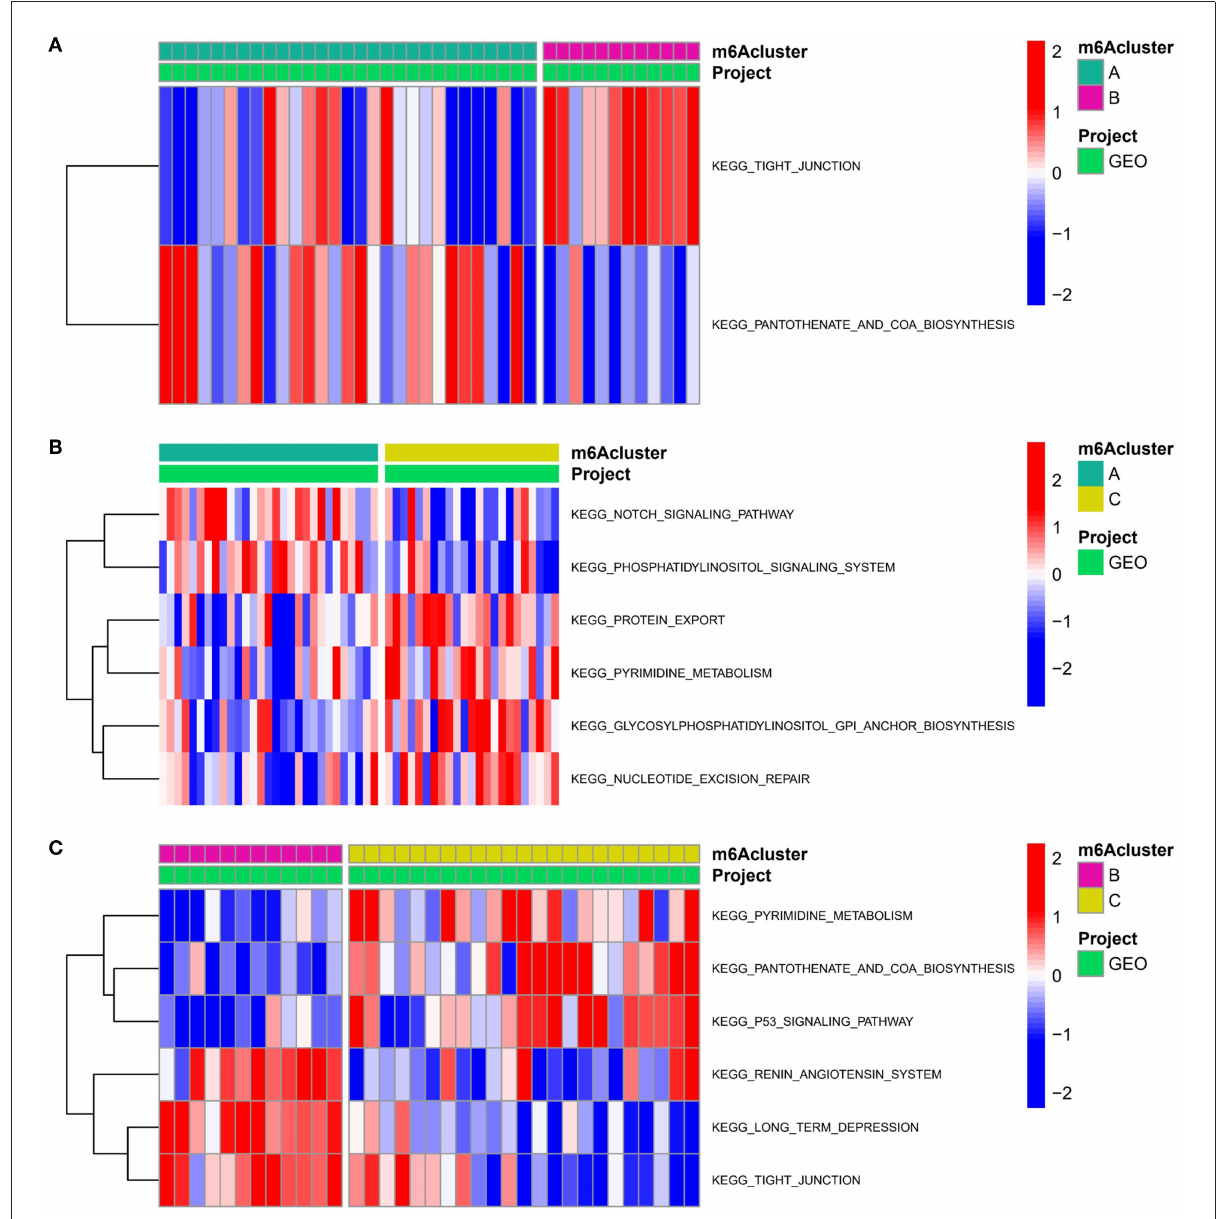
FIGURE8 Underpinned biological functional features of three m6A modification sequences. (A–C) Differences in the KEGG pathway enrichment scores for m6A modification (A) patterns A and B; (B) patterns A and C; and (C) patterns B and C.